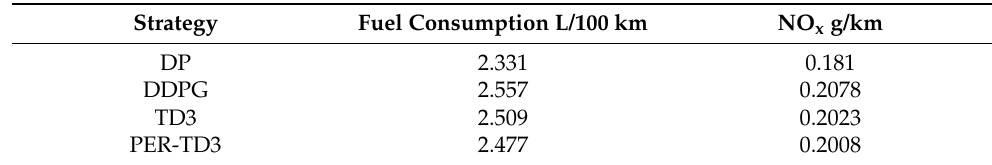
Figure 16 . Distribution of the engine workload on the NO x emissions map. Table 3. Comparison of the performance for four